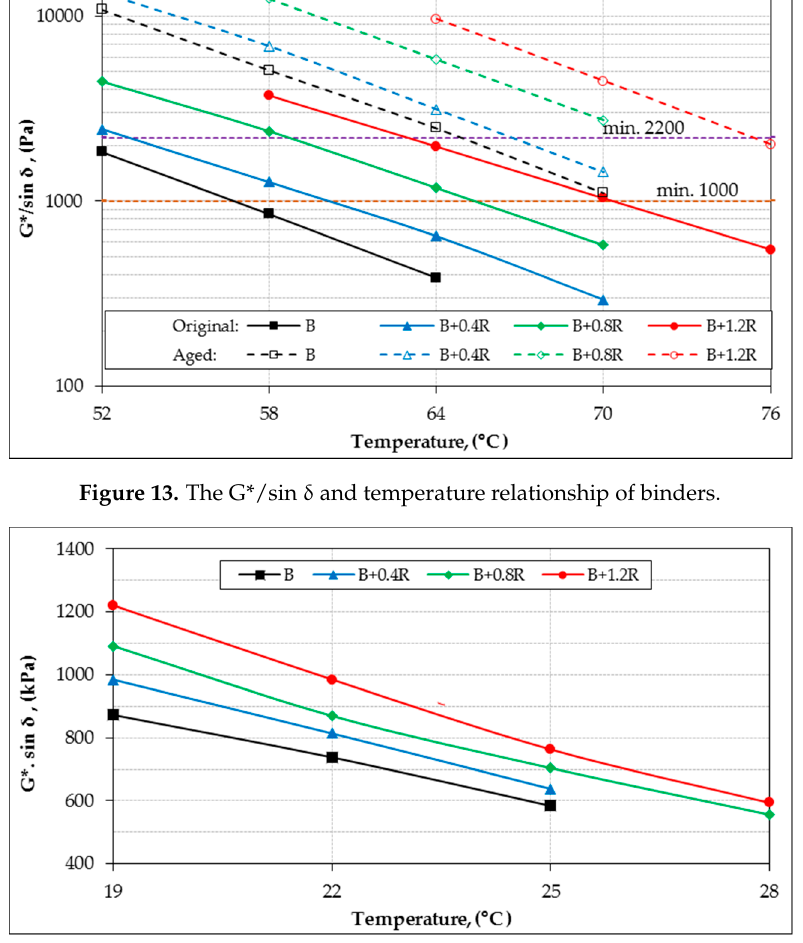
Figure 14. The G*.sin δ and temperature relationship of binders.